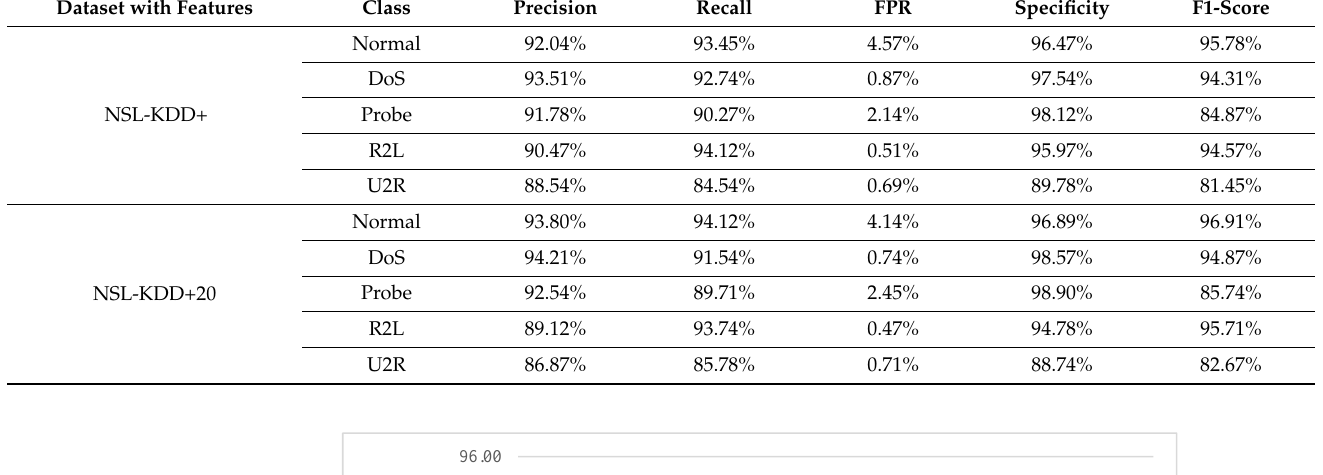
Table 1. The outcome of the proposed model for multi-class classification.